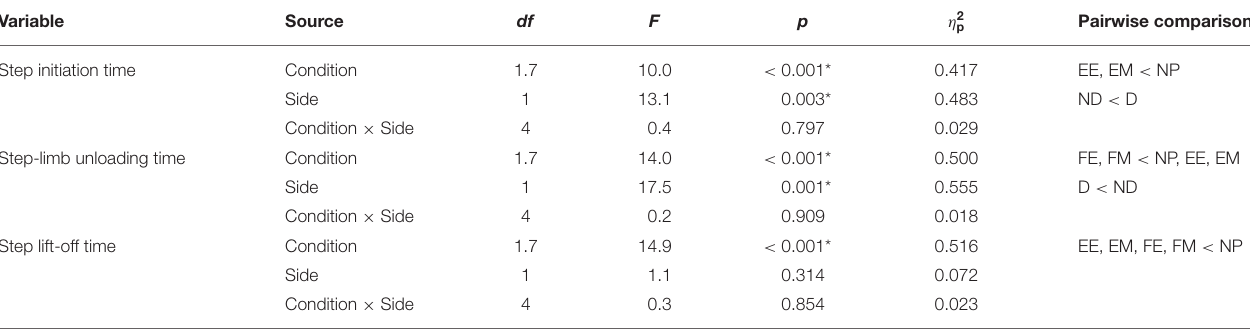
TABLE 1 | Two-way ANOVA summary table for step-initiation characteristics.